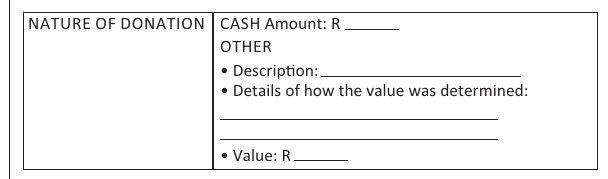
FIG URE 2: Extract from example provided by South African Revenue